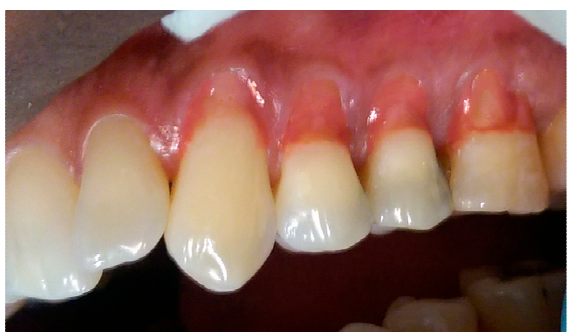
Figure 3. Light and white opaque placement.